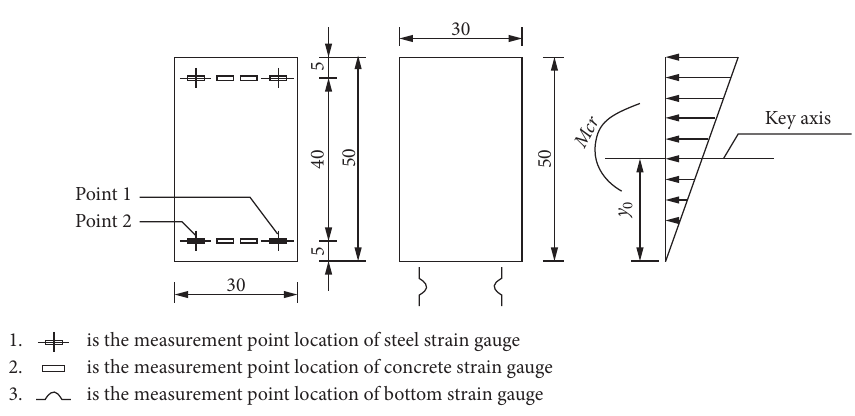
Figure 3: Instrument installation at the mid-span section of test beam.